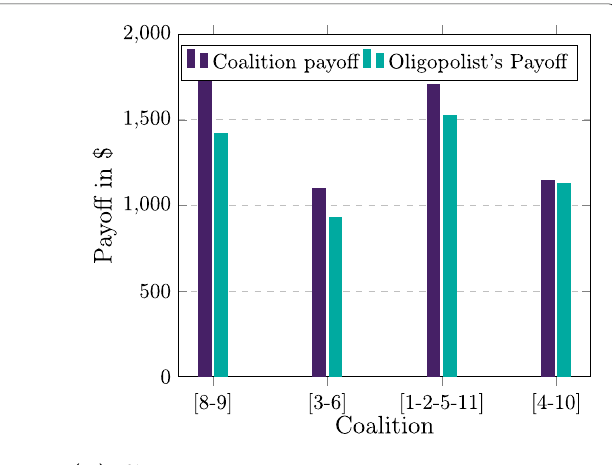
This is due to the imbalance in the core and memory ratio. randomization in the initial resource assignment to cloud providers in our experimental setup. Without these out- liers, the average over-estimation error reduces to 10.5